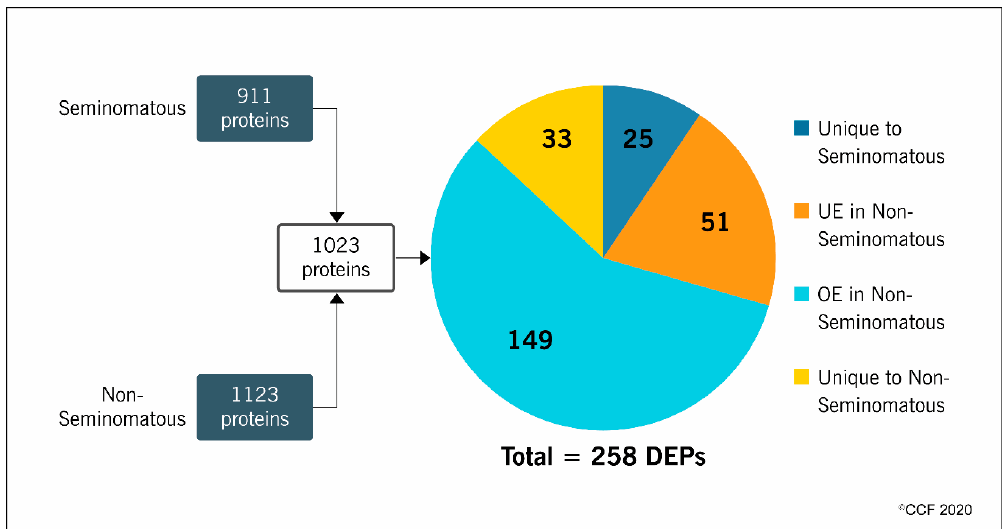
Figure 1. Number of proteins identified by proteomic analysis of spermatozoa samples obtained from patients with seminomatous and non-seminomatous testicular germ cell tumors, and expression profile of the differentially expressed proteins (DEPs) identified after comparative analysis between the experimental groups. OE, overexpressed; UE, underexpressed.